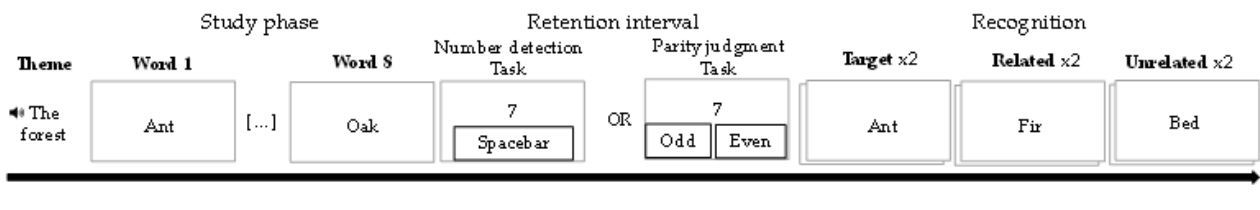
Figure 1. Illustration of the experimental procedure.